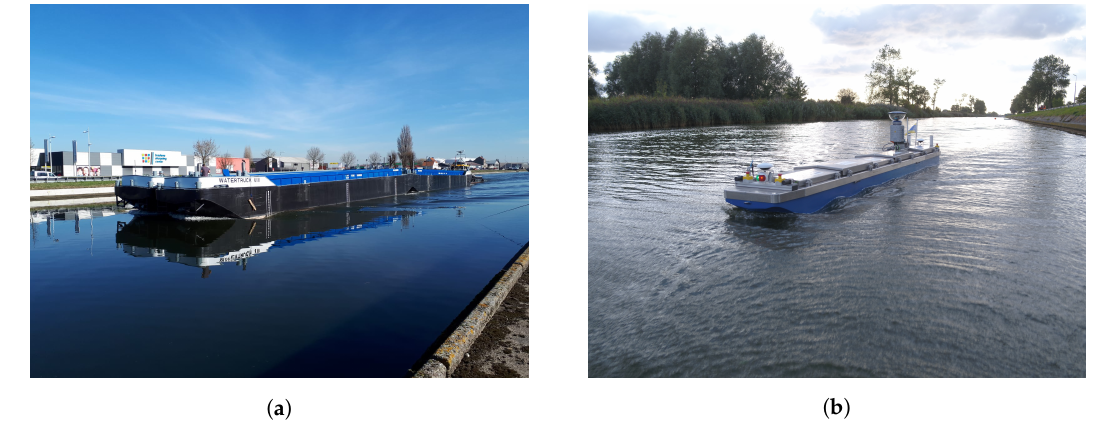
Figure 1. The Watertruck + concept [32]: ( a ) four real-size barges pushed by a push boat, reproduced from [5] with permission from Elsevier, 2020, ( b ) the KU Leuven scale model of a self-propelled barge named Cogge